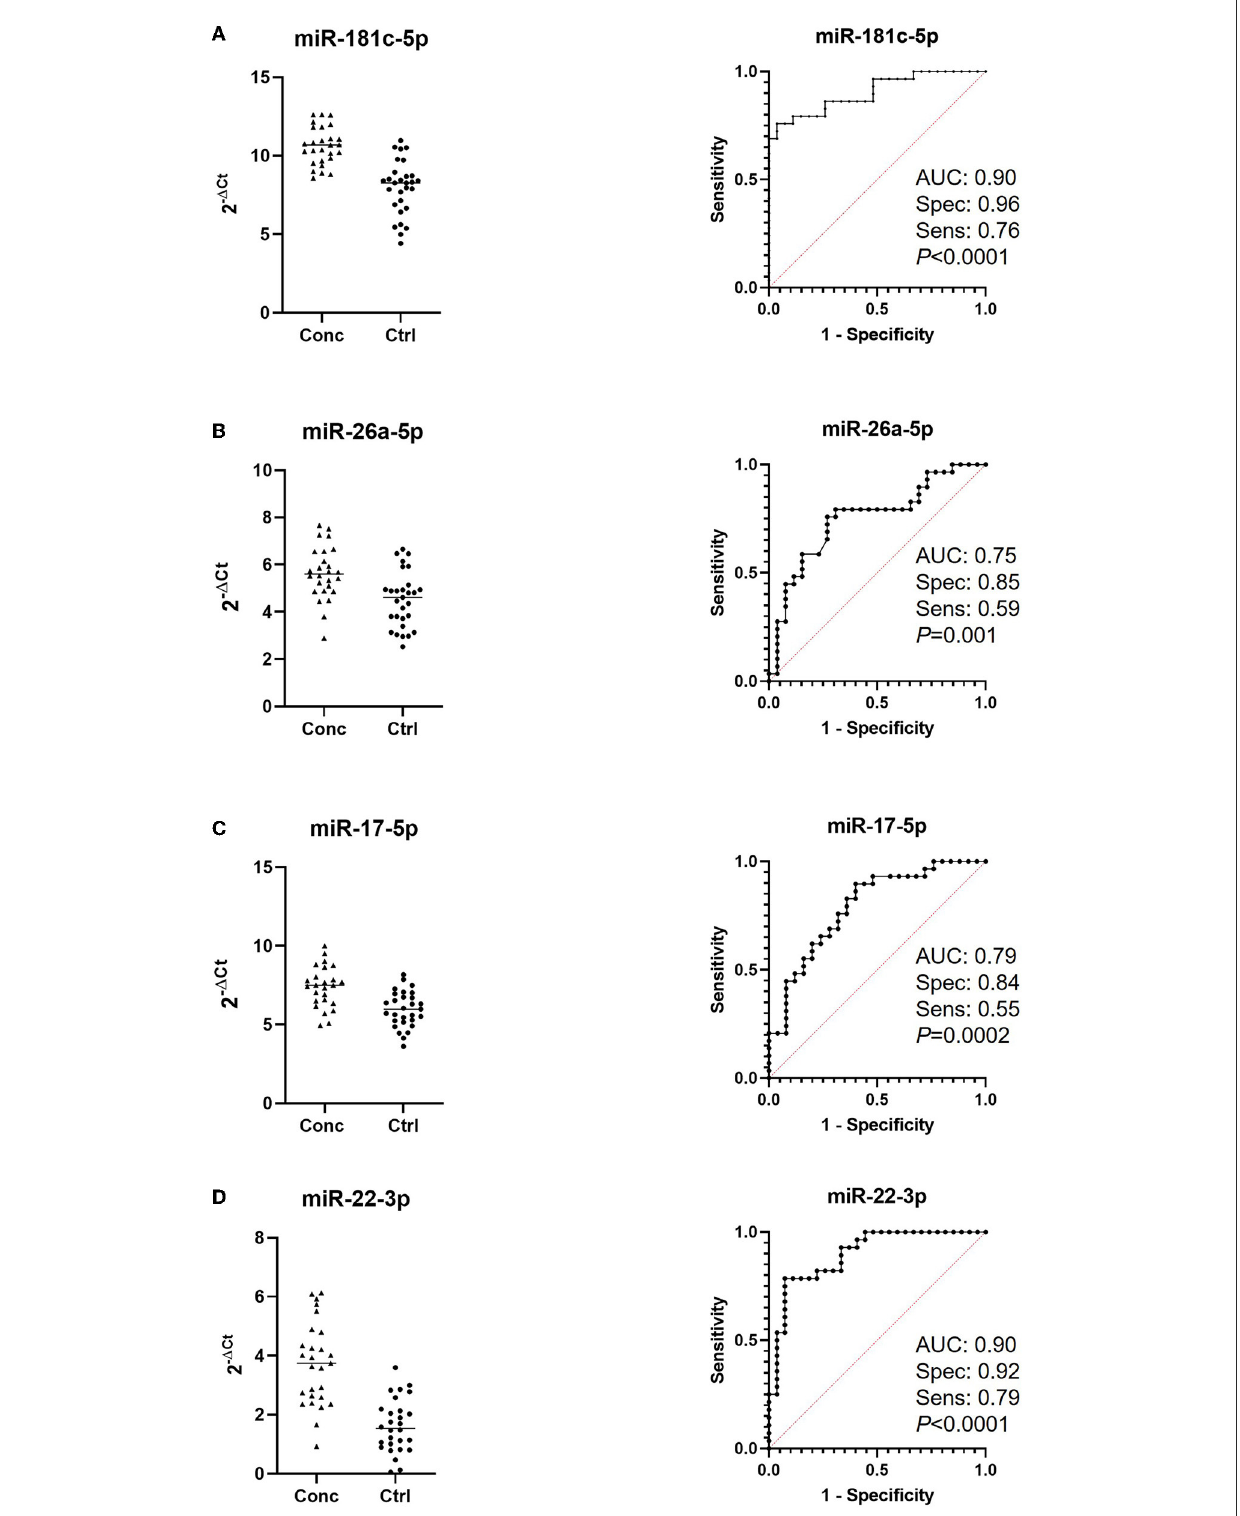
FIGURE2 Receiver-Operating Characteristic (ROC) analysis of miRNAs discriminating concussed players from controls. Left panels indicate relative expression of the indicated miRNAs in concussed and control players. Note that higher Cts indicate lower expression. Area under the curve (AUC), sensitivity and specificity are calculated for the cutoff point and are indicated in the ROC graphs together with the p -values (right panels); (A) miR-181c-5p (concussed n = 27, controls n = 29); (B) miRNA-26a-5p (concussed n = 26, controls n = 29); (C) miRNA-17-5p (concussed n = 25, controls n = 29); (D) miR-22-3p (concussed n = 27, controls n =